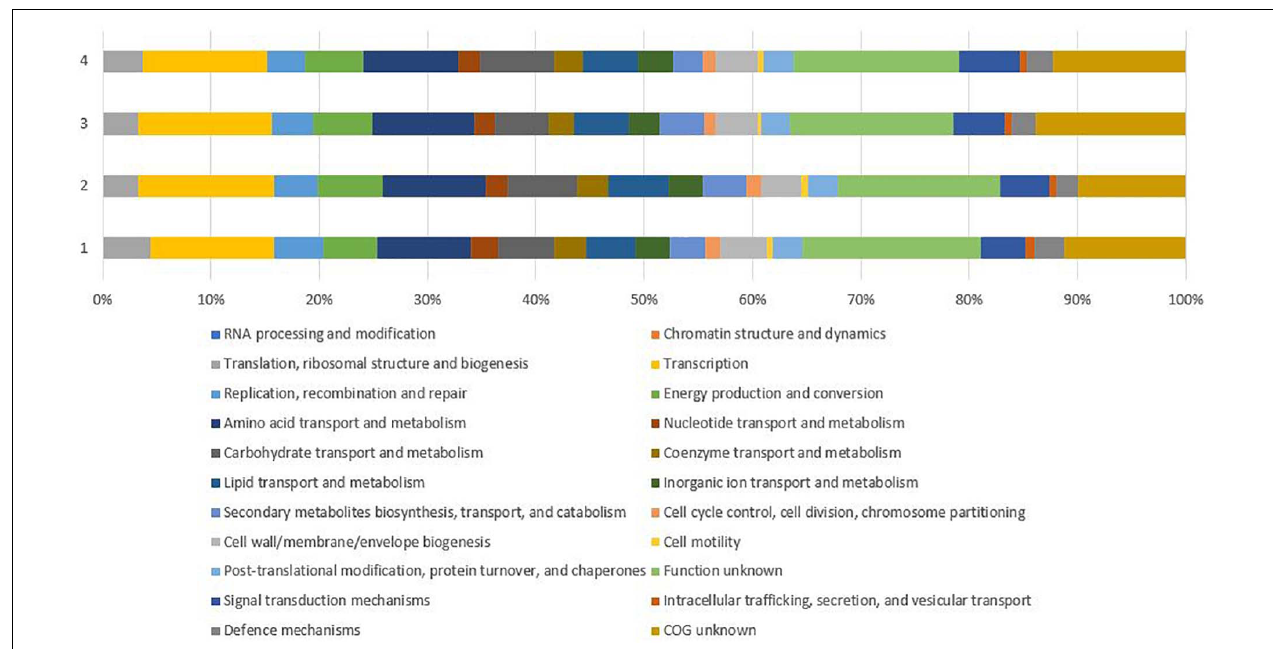
FIGURE 4 | Comparison of gene functional categories of the strain P38-E01 T and the phylogenetically closest Streptomyces spp. identified in the 16S rRNA phylogenetic analysis. 1, strain P38-E01 T ; 2, S. daliensis DSM 42095 T ; 3, S. rimosus subsp. rimosus ATCC 10970 T ; 4, S. sclerotialus NRRL ISP-5269 T